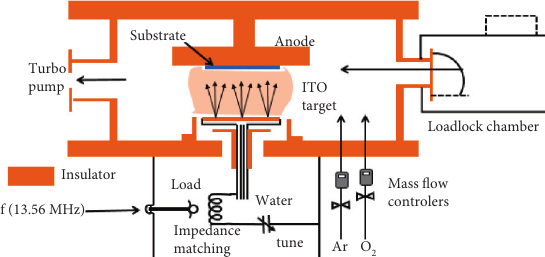
Figure 19: Schematic diagram of RF magnetron sputtering.